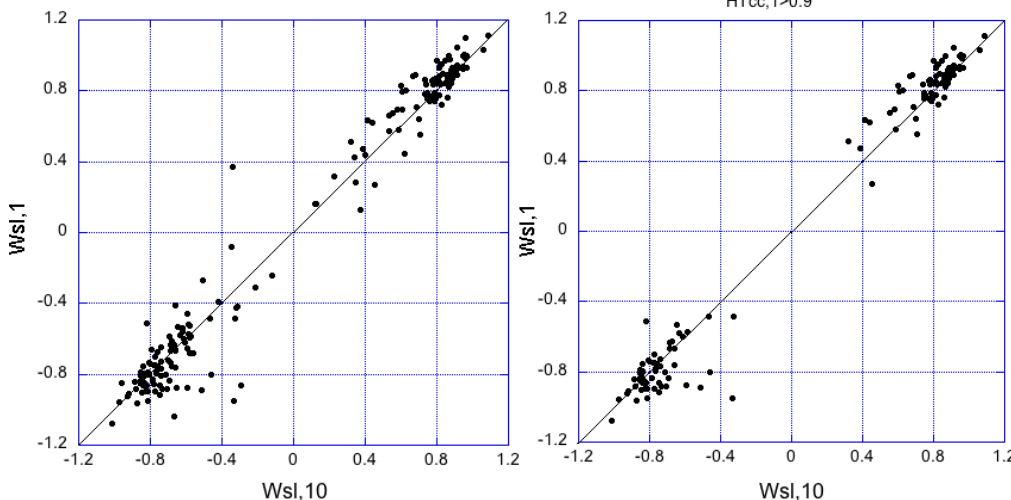
Fig. 7. Scatterplots of the 1min and 10min Wal´en slopes for all cases (left) and for cases with HT cc , 1 ≥ 0.9 (right).